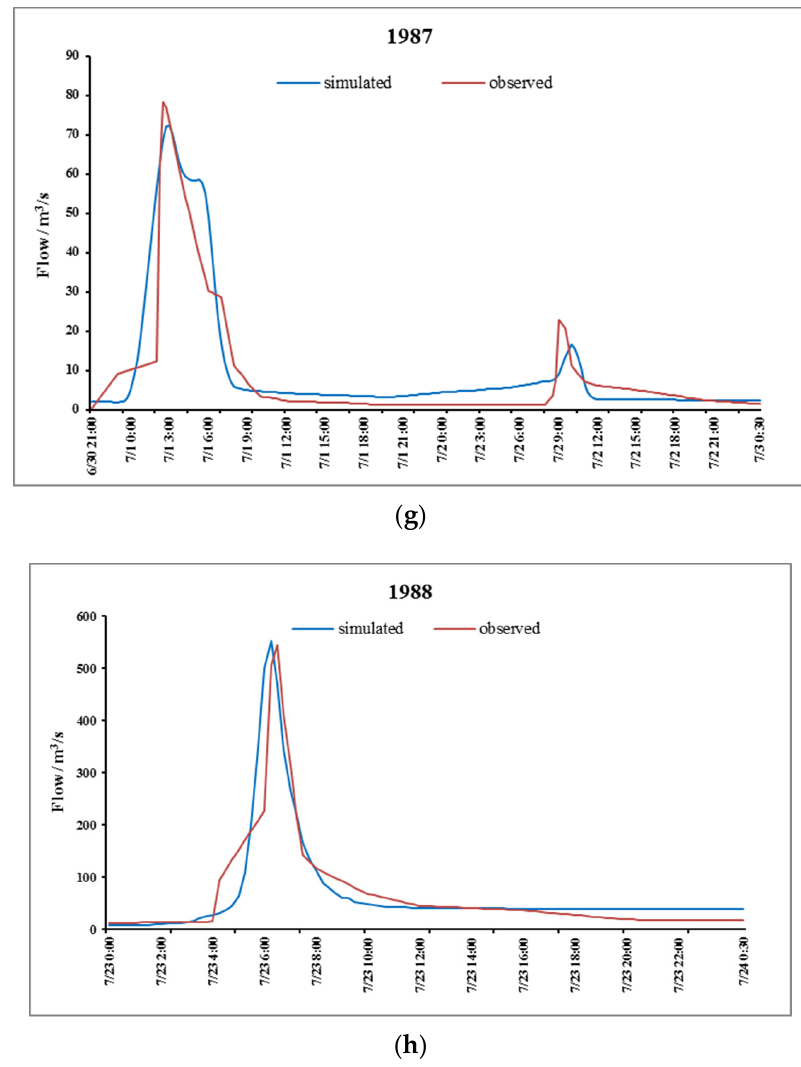
Figure 8. Observed and simulated hydrographs of the 1970s and 1980s.